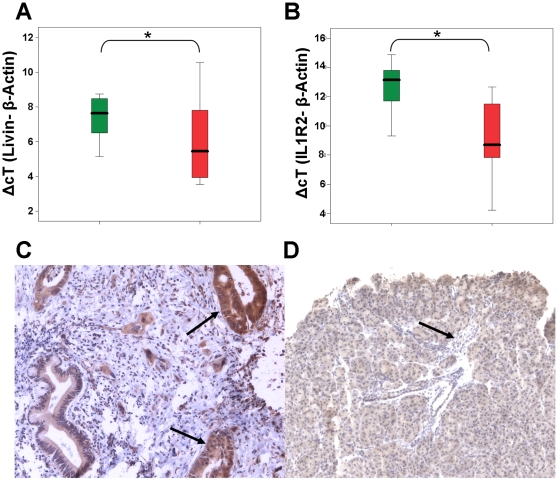
Validation of differential expressed genes by quantitative RT-PCR.The graphs display the results of the quantitative RT-PCR in normal tissue of the pancreas and pancreatic adenocarcinoma of Livin/BIRC7 (t-test with p = 0.01) (A) and IL1R2 (t-test with p = 0.035) (B). Immunohistochemical staining for Livin/BIRC7 in benign pancreas and invasive adenocarcinoma. Pancreatic carcinoma (arrow) showing intensive cytoplasmic staining (original magnification x100)(C). Benign ductal epithelium shows a noticeable fainter staining (arrow) (original magnification ×40)(D). * indicates p-value <0.05.